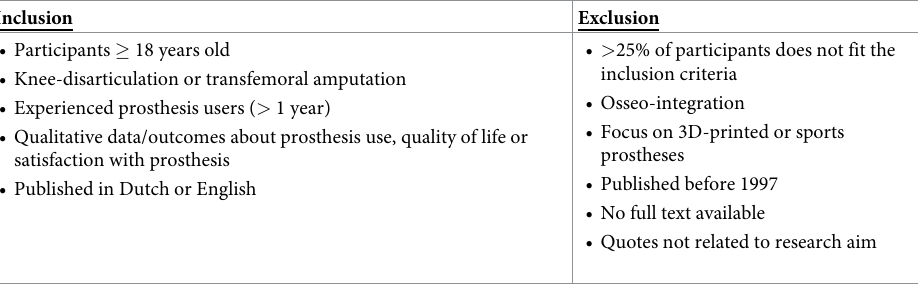
Table 1. Eligibility criteria for